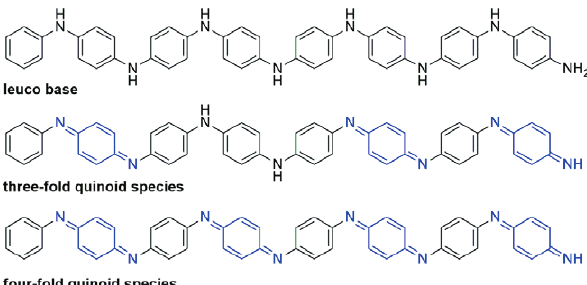
Figure 10. Proposed oxidative states representative of aniline black (quinoid units highlighted in